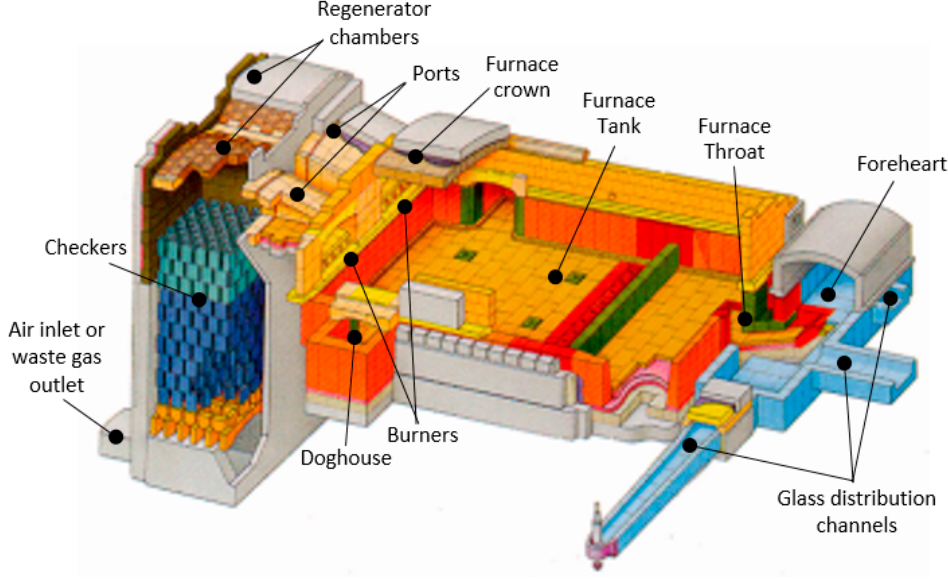
Figure 1. End-port (EP) glass furnaces design.